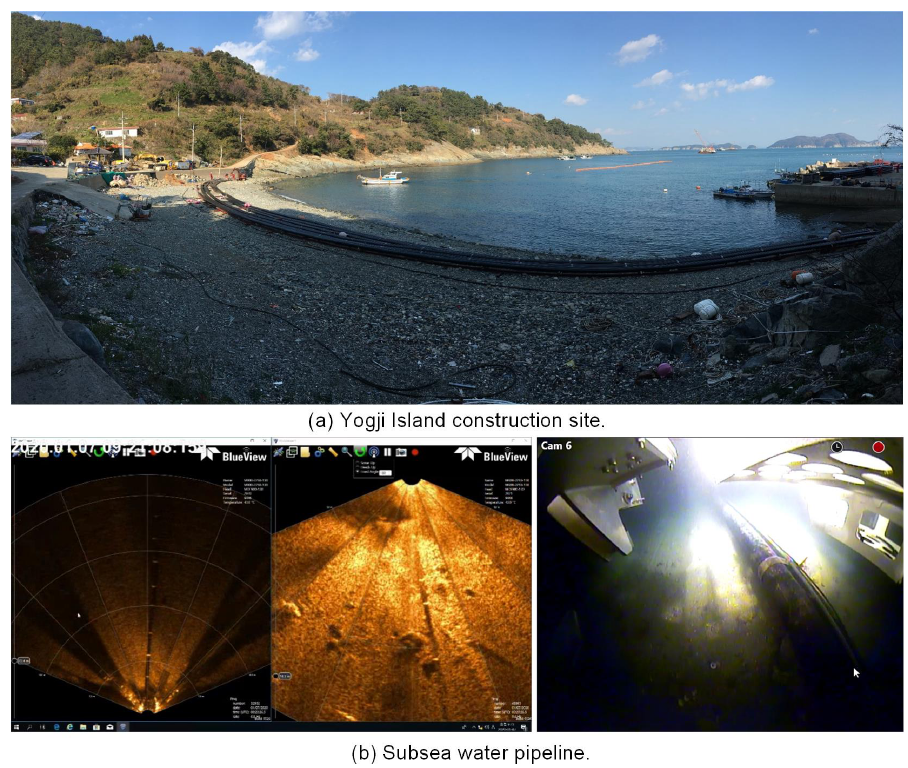
Figure 17. Subsea water pipeline burial site. ( a ) Yogji Island construction site, ( b ) subsea water